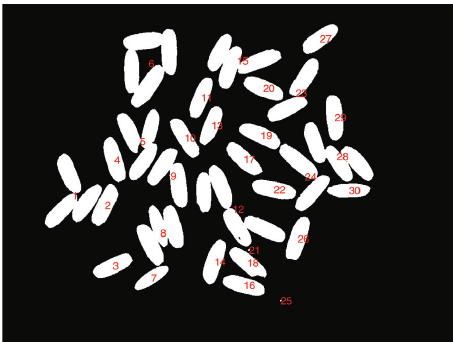
Figure 4: Rice area marker image.